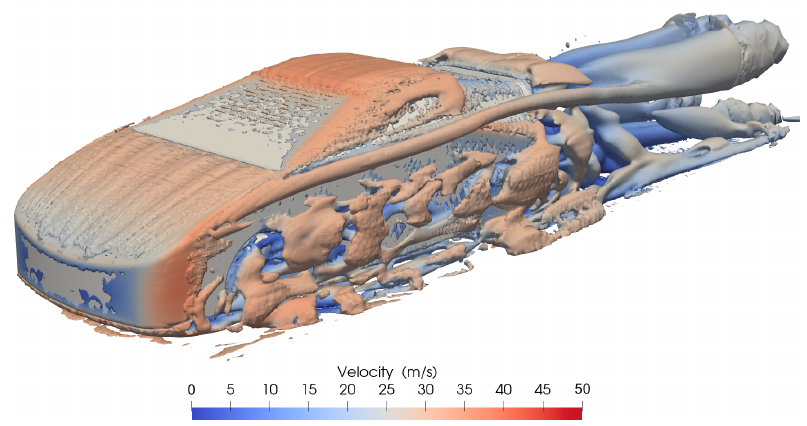
Figure 18. Iso-contour of Q = 50,000 s − 2 around the baseline configuration.